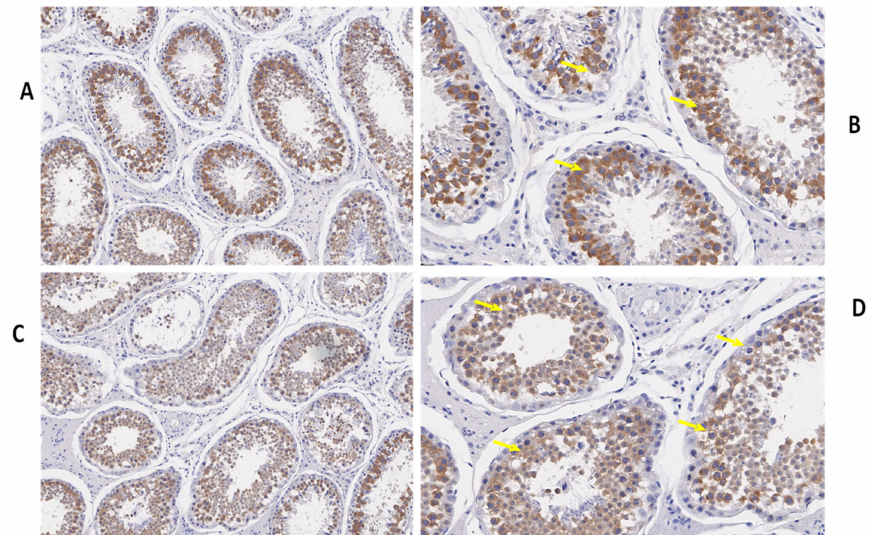
Figure 4. Immunohistochemical localization of BOLL protein in the testes of yaks under different feeding conditions. Immunohistomestry indicated that boll protein was present in both groups but positive cells (yellow arrow) were more prominent in the tubules of the concentrate supplementation group as compared to the group without concentrate supplementation: ( A , B ) natural grazing plus concentrate supplementation; ( C , D ) natural grazing without concentrate supplementation. Scale bar = 50 µ m ( A – D